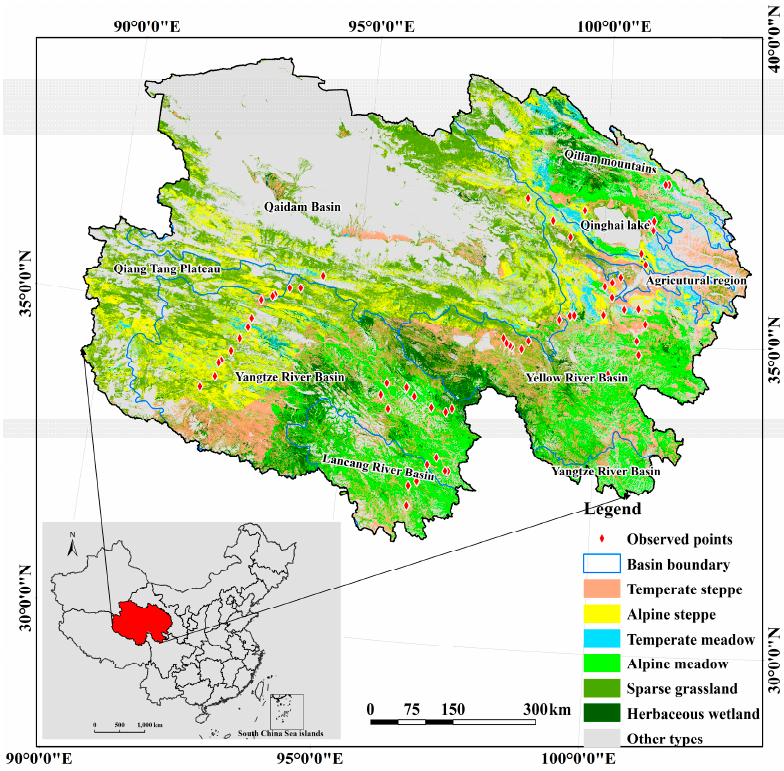
Figure 1. Location of the study area and spatial distribution of six grassland types in Qinghai province. 91